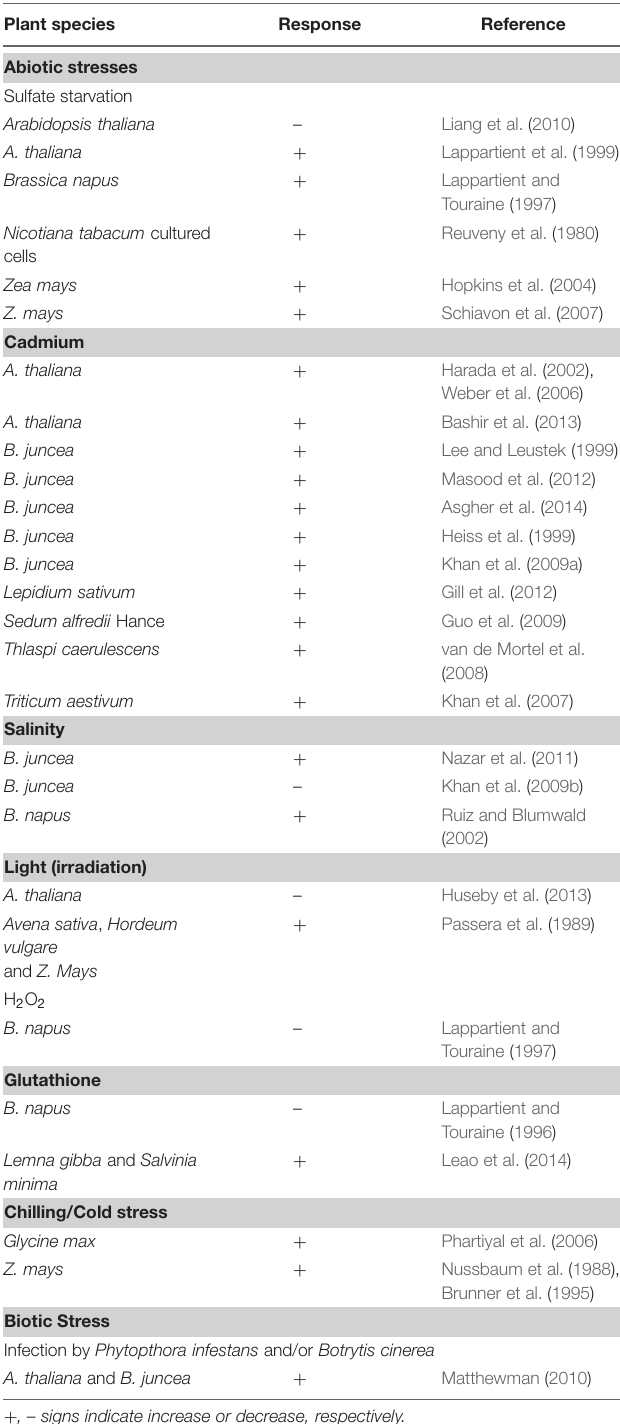
TABLE 1 | Summary of representative studies on ATP-S activity or expression modulation/regulation in abiotic and biotic stressed plants. Plant